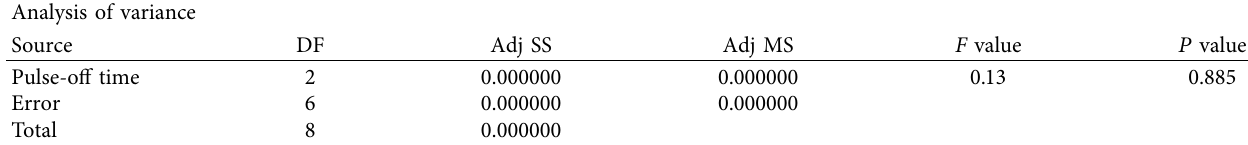
Table 20: One-way ANOVA: MRR vs. pulse-off time for mild